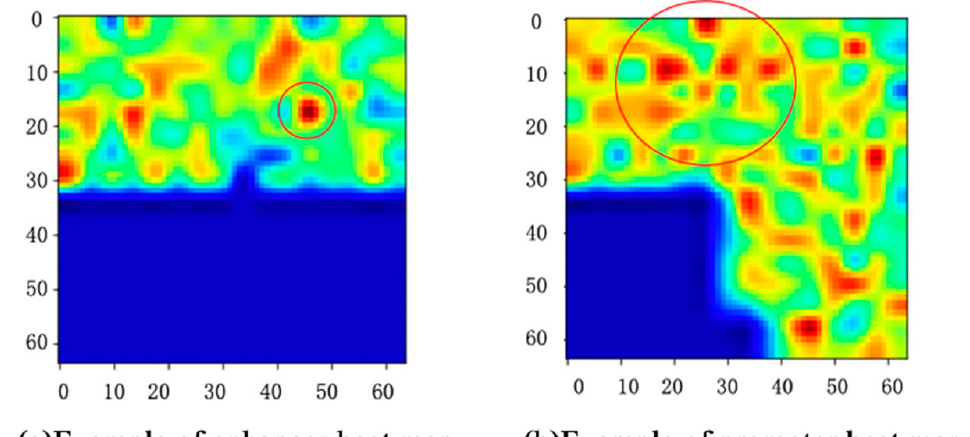
Figure 5. Example of CAM.